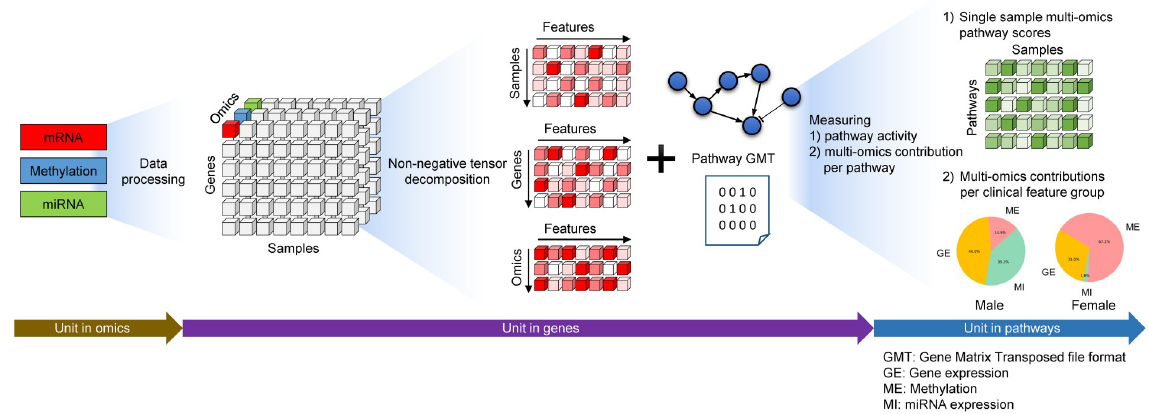
Fig 2. The conceptual workflow of MOPA. The sequential conversion of omics to gene and then to pathway level enrichment scores is shown.